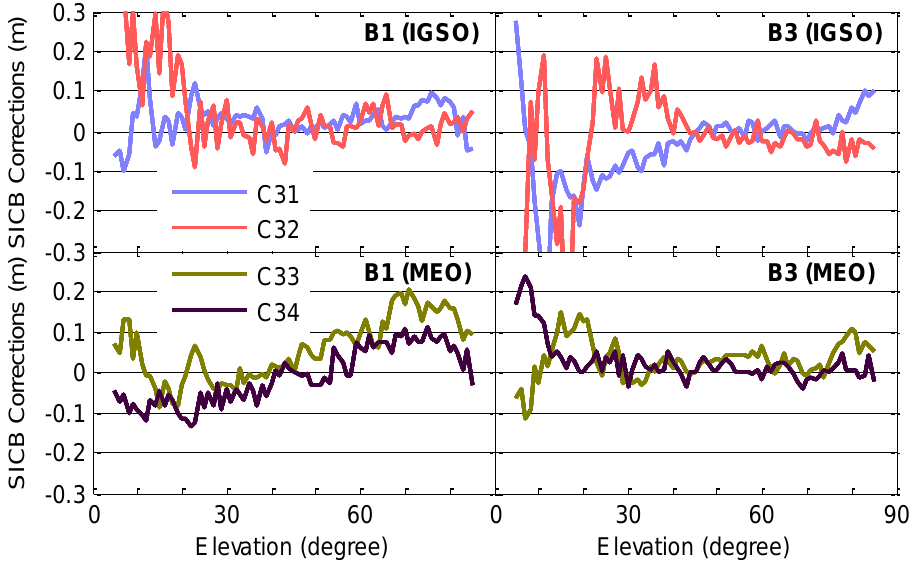
Figure 11. SICB correction model as a function of elevations on B1 and B3 frequencies for each BDS-3S MEO and IGSO satellite.